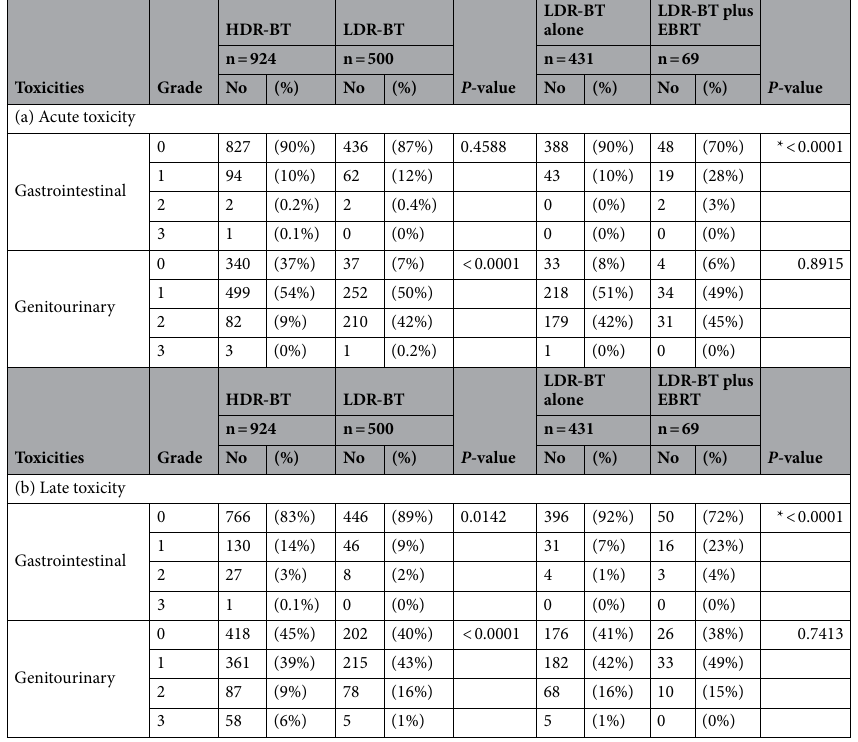
Table 5. Comparisons between HDR-BT and LDR-BT for toxicities. HDR‑BT high dose rate brachytherapy, LDR‑BT low-dose-rate brachytherapy, EBRT external beam radiotherapy. * P value was calculated excluding columns of grade